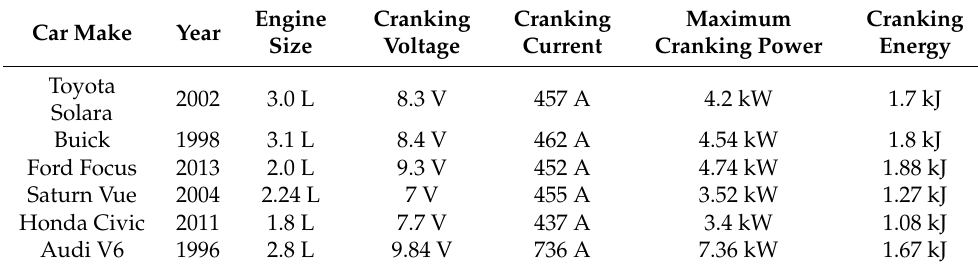
Table 1. Engine cranking requirements for a number of car models [2].